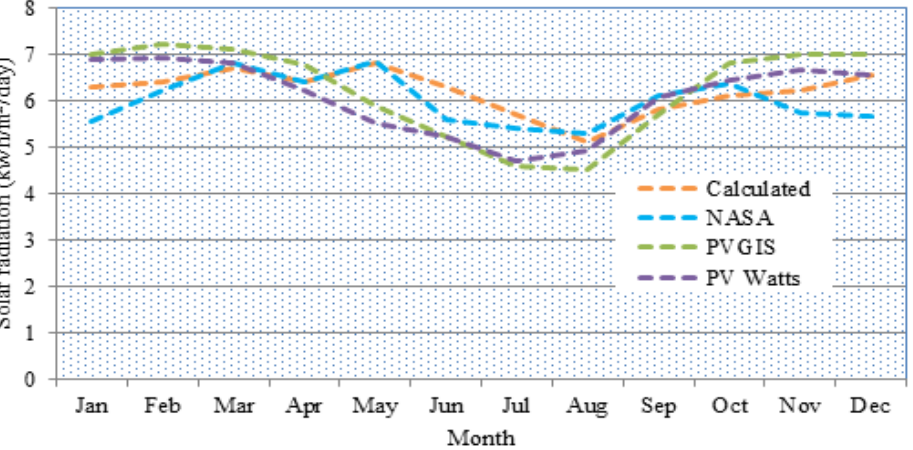
Figure 4. Monthly average analyzed, NASA, PVGIS, and PVWatts solar irradiation values for the site. To obtain the real power output from solar PV power, recognizing the ambient tem- perature of the site is very essential. Figure 6 indicates the average monthly temperature of the site obtained from the National Meteorology Agency of Ethiopia. The yearly average temperature in the location is 21.59 ◦